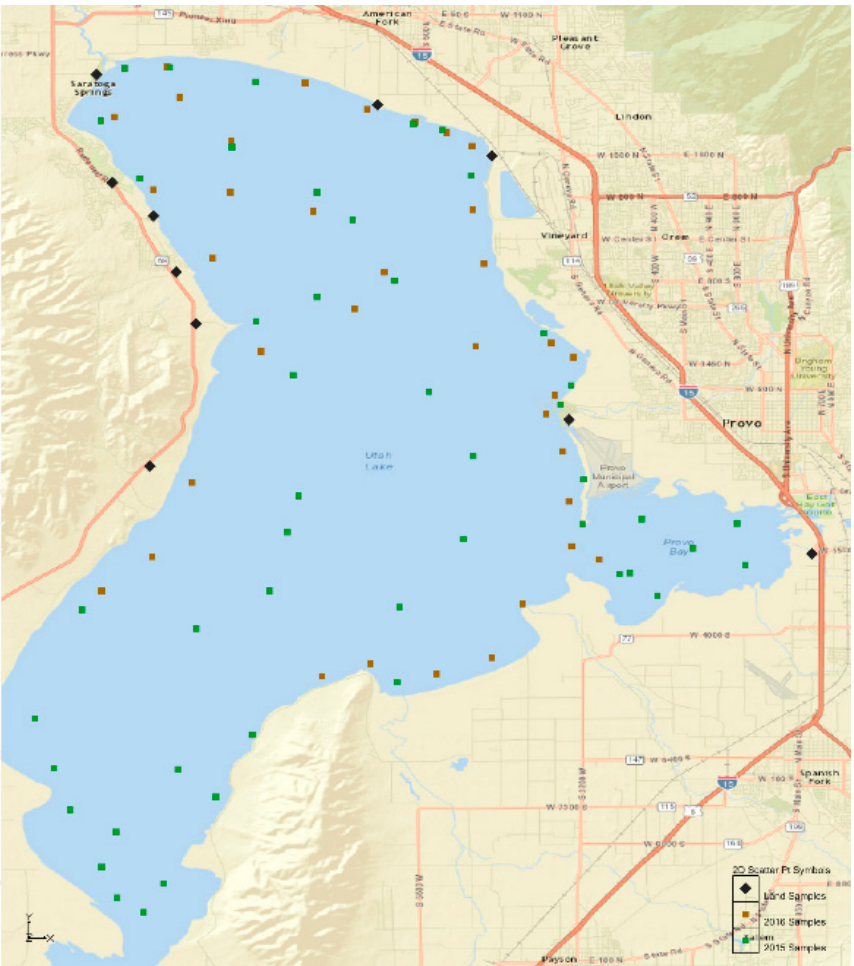
Figure 4. A map showing the location of the sediment and soil sample points, the figure indicates sediment points sampled in 2015 as blue squares, sediment points sampled in 2016 as red circles, and samples taken on the shore as black triangles, which represent geologic lake sediments.